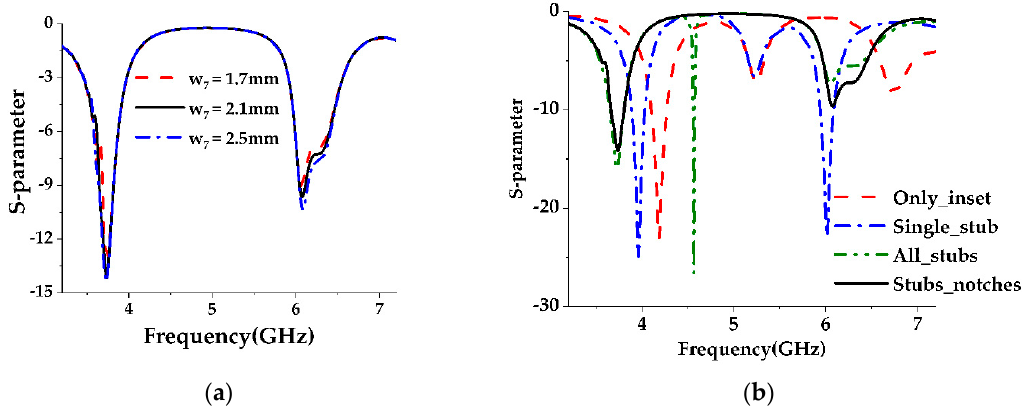
Figure 2. Parametric analysis of the stub-notch configuration. ( a ) Effect of the notch width (w 7 ) on the passband frequencies; ( b ) Effect of the stub-notch configuration on the passband frequencies.